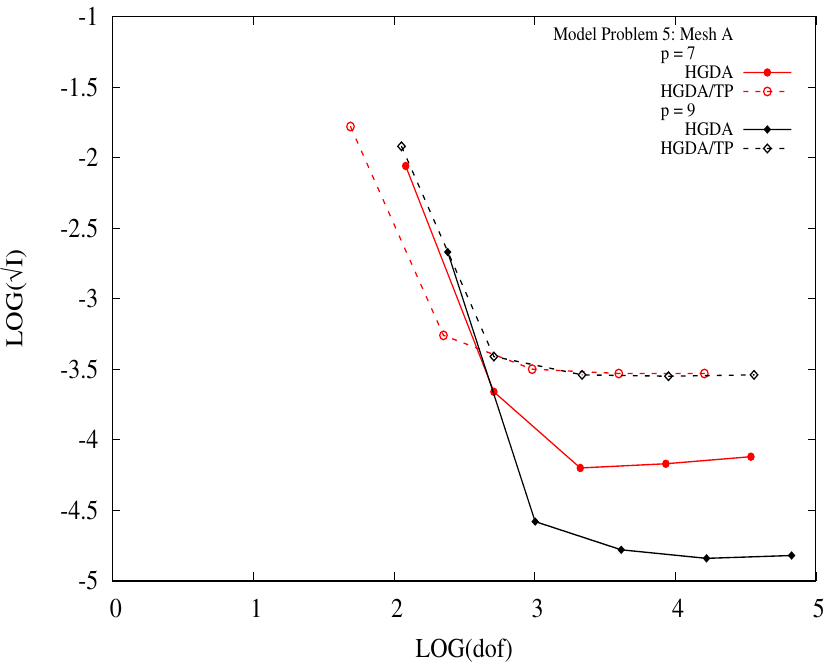
Figure 24. Residual function I versus dof, C 33 solutions: Model Problem 5 (Convection Diffusion Equation; Mesh A; HGDA/DG and HGDA/TP).